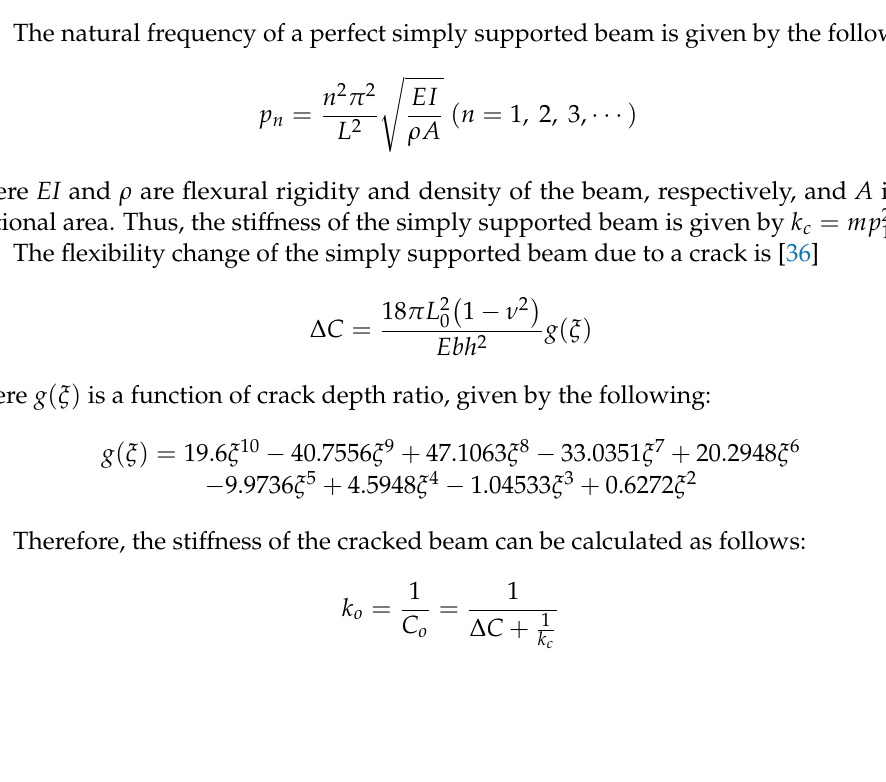
Figure 1. A simply supported beam with a breathing crack.